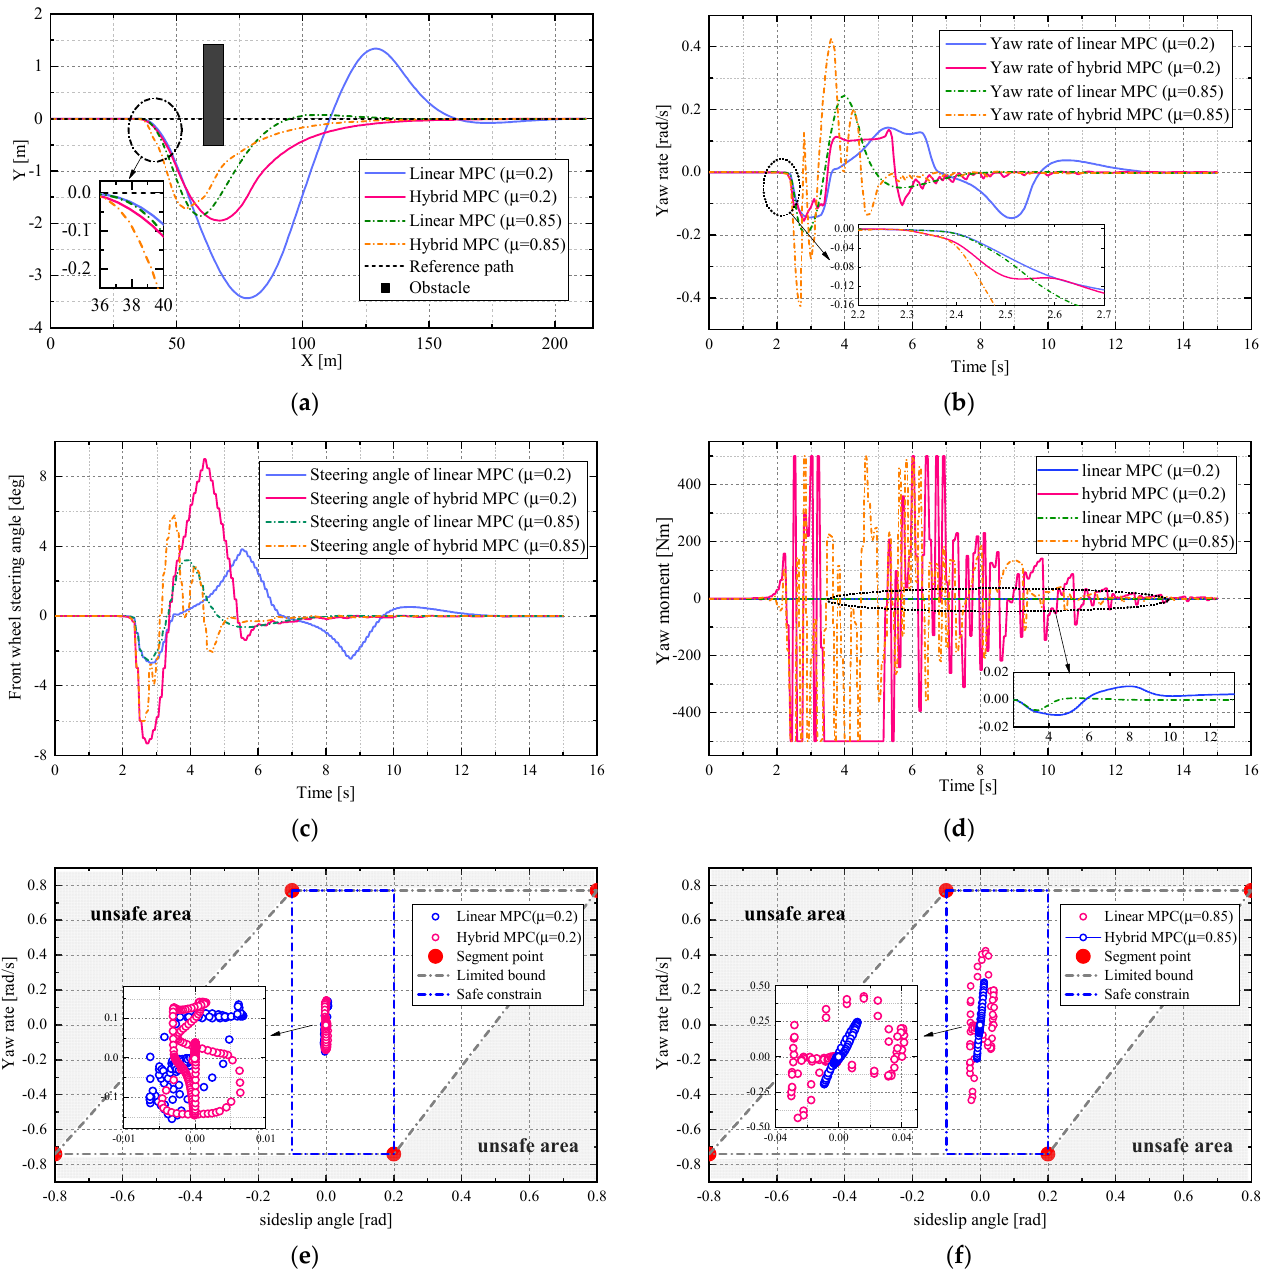
Figure 10. Simulation results in the variable collision avoidance scenario. ( a ) Path tracking performance; ( b ) Yaw rate comparison; ( c ) Steering angle comparison; ( d ) Yaw moment comparison; ( e ) State trajectories in low-adhesion condition; ( f ) State trajectories in high-adhesion condition.